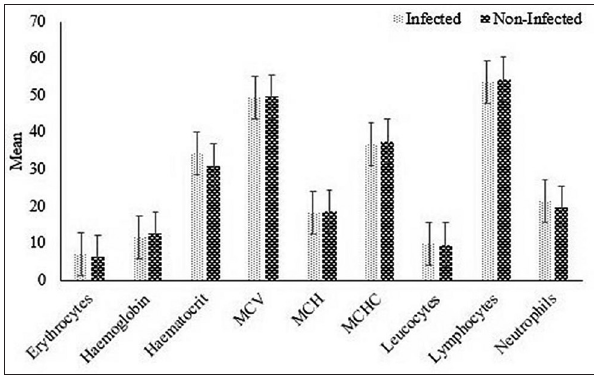
Figure-1: Hematological profile of Bali cattle with and without